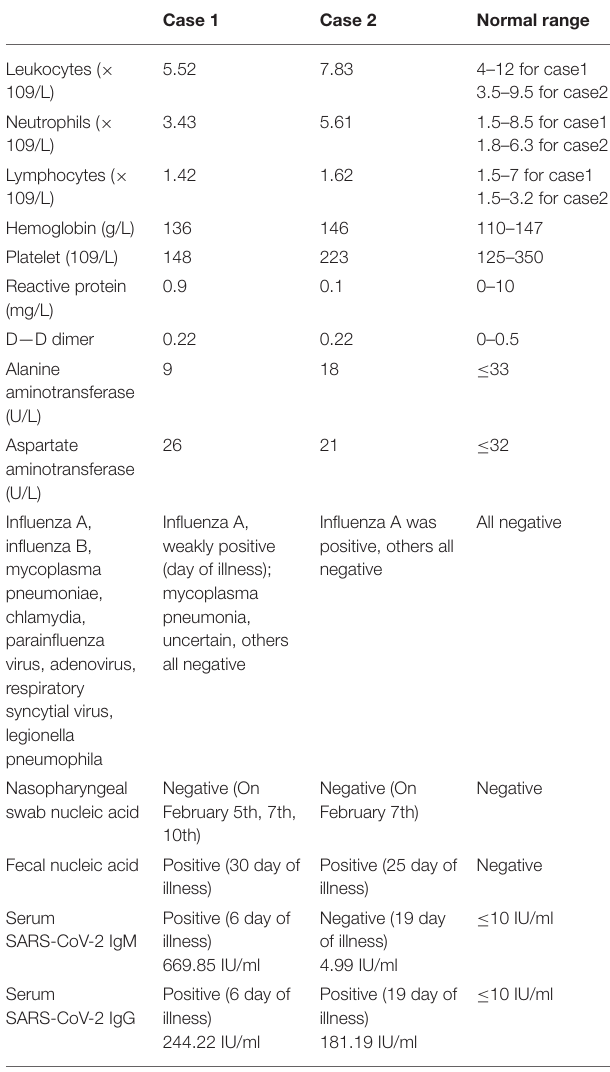
TABLE 1 | Results of Laboratory